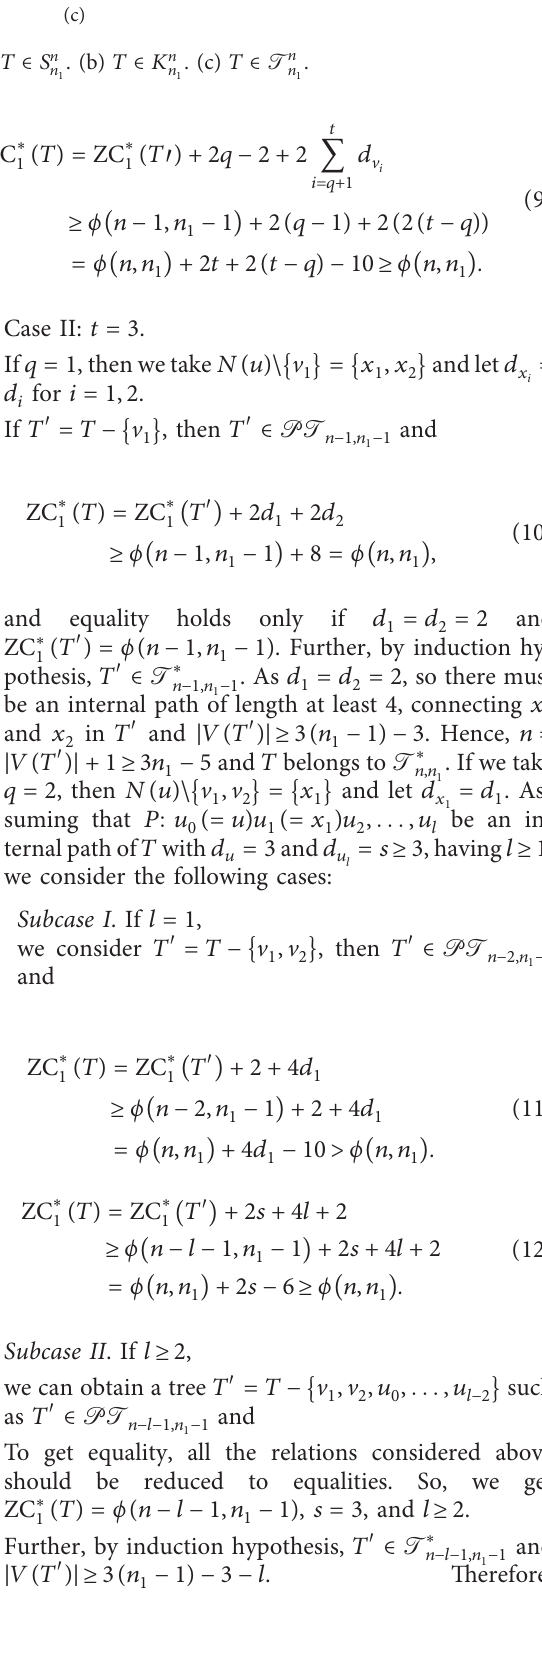
T ∈ S n T ∈ K n T ∈ T n n,n 1 . (a) n 1 . (b) n 1 . (c) n 1